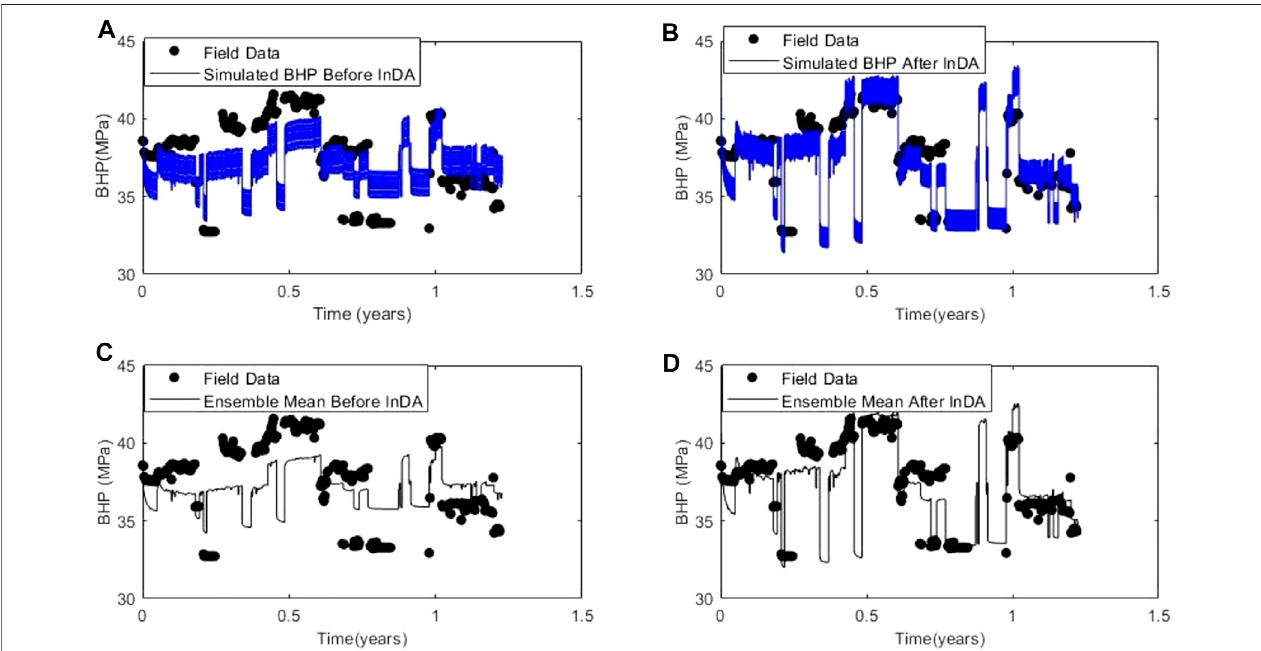
FIGURE 13 | History Matching Results. (A) simulated bottom-hole pressure before InDA, (B) simulated bottom-hole pressure after InDA, (C) Ensemble mean before InDA, and (D) Ensemble mean after InDA.